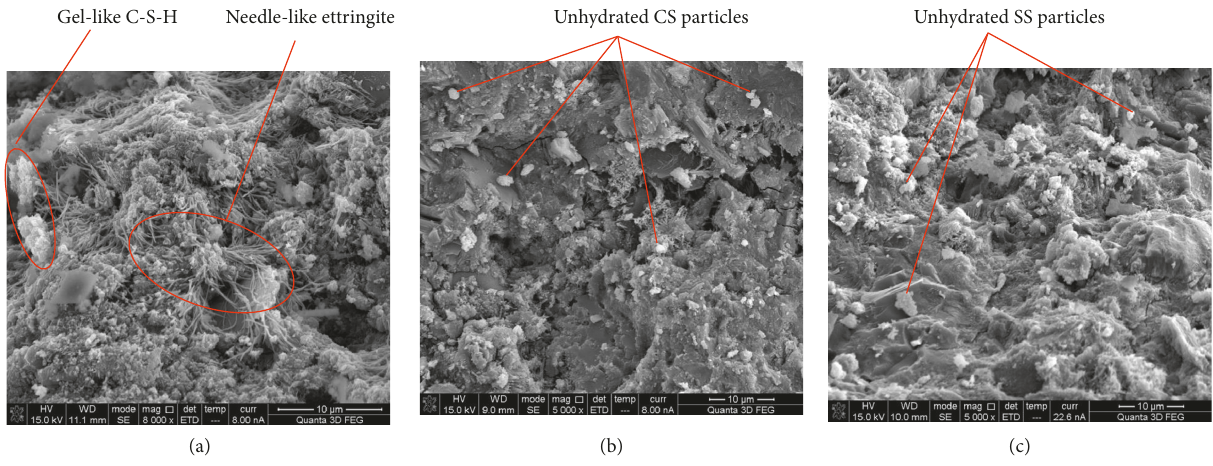
Figure 9: SEM at 3 days of (a) OPC, (b) CS30, and (c) SS30.